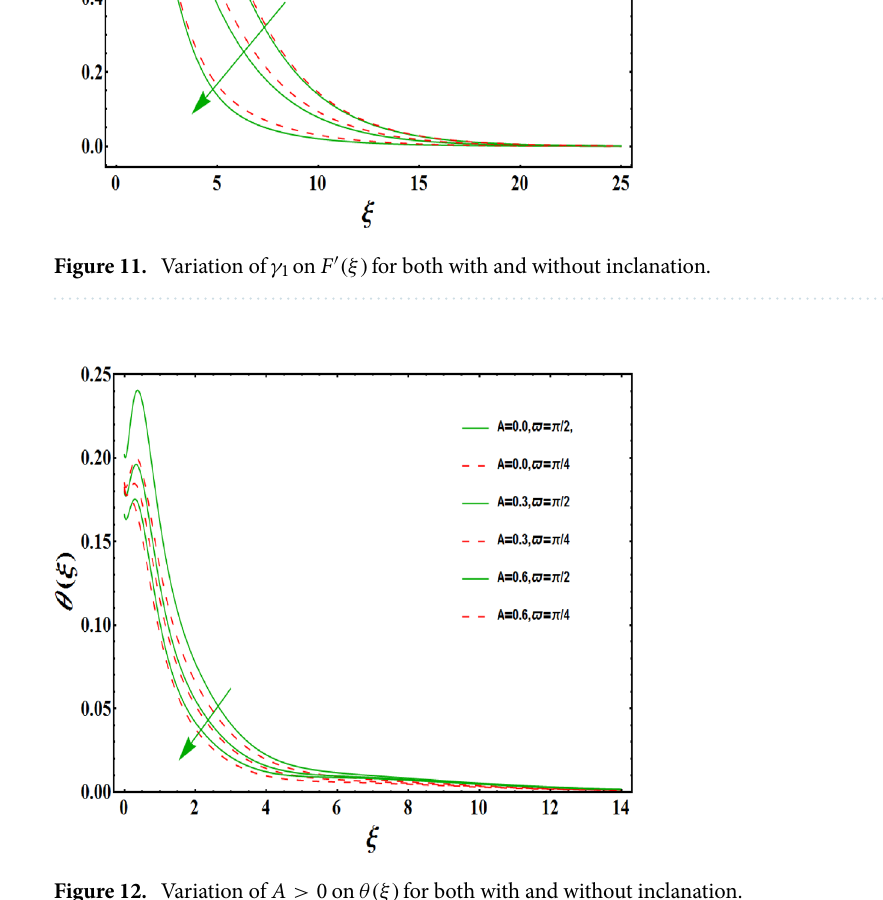
Figure 12. Variation of A > 0 on θ(ξ) for both with and without